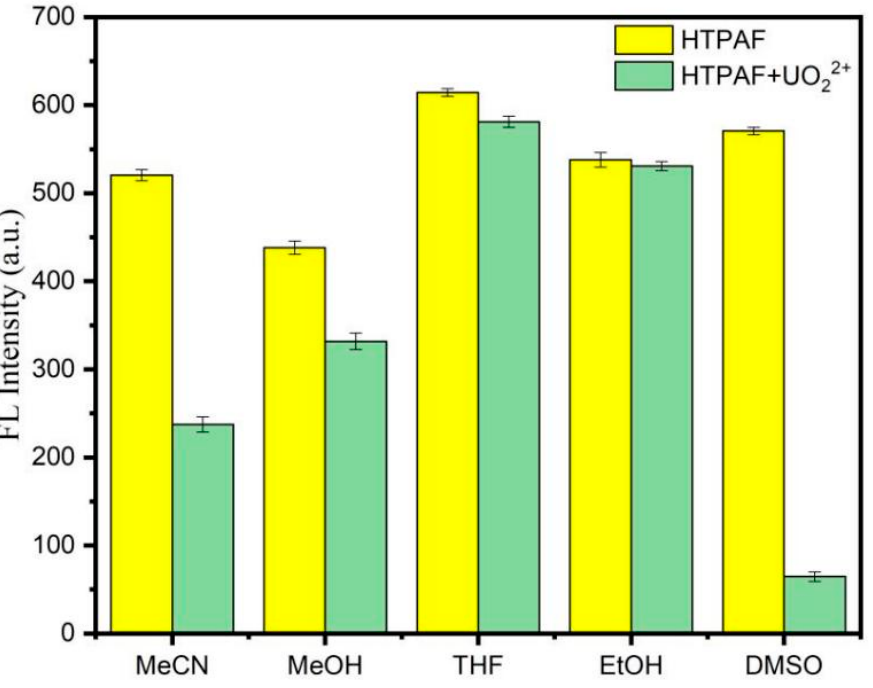
Figure 1. Fluorescence intensity of HTPAF and HTPAF+UO 22+ systems in various organic solvents (MeCN, MeOH, THF, EtOH, and DMSO) (HTPAF, 50 μ M, UO 22+ ,50 μ M).